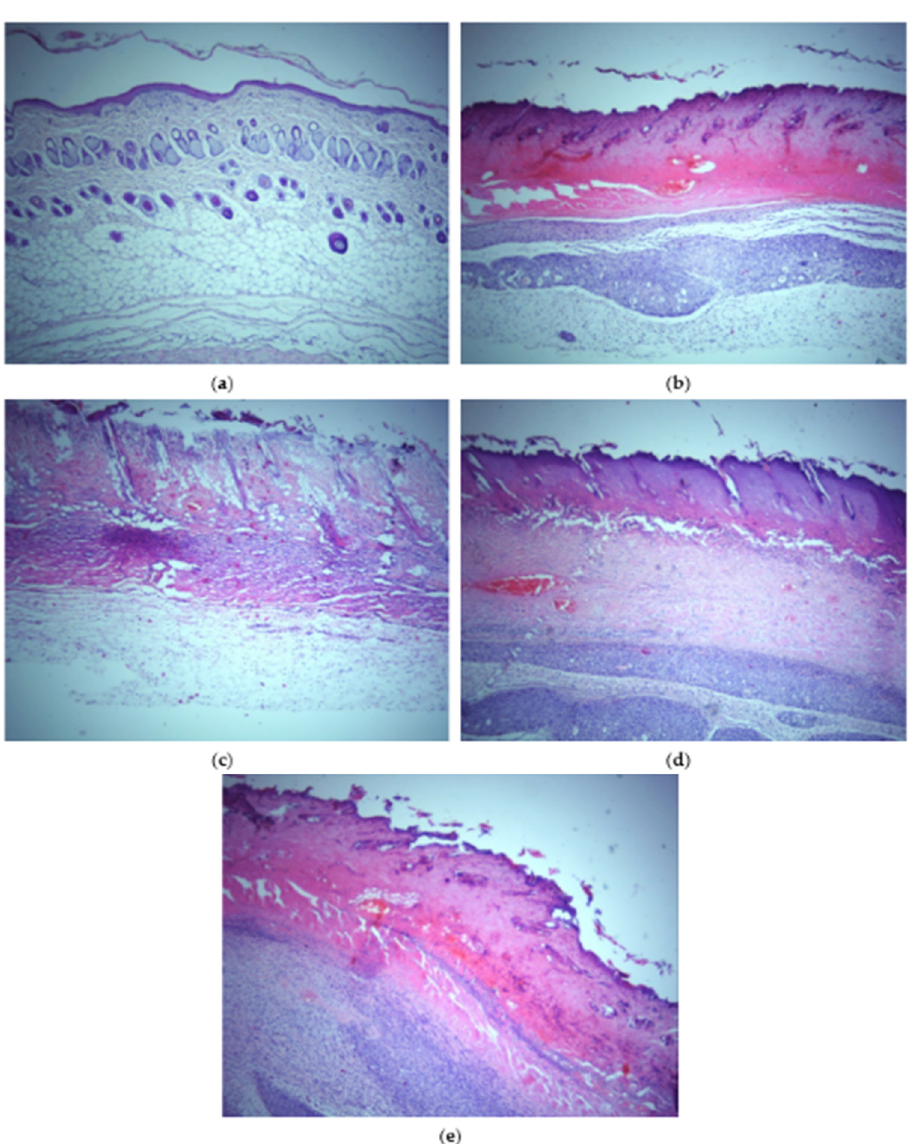
Figure 11. Histopathological observation of H&E stained skin sections (200 × ) of ( a ) healthy skin, ( b ) burned skin, ( c ) burned skin treated with the Car/Alg/Pol film, ( d ) burned skin treated with the Car/Alg/Pol-Dlf film, and ( e ) burned skin treated with the Car/Alg/Pol-Cur+Dlf film. Analysis of paraffin sections of skin tissue of untreated animals, stained by hematoxylin- eosin technique, showed a healthy skin structure. Epidermis, dermis, and subcutaneous adipose tissue had normal histological structure, with intact sweat and sebaceous